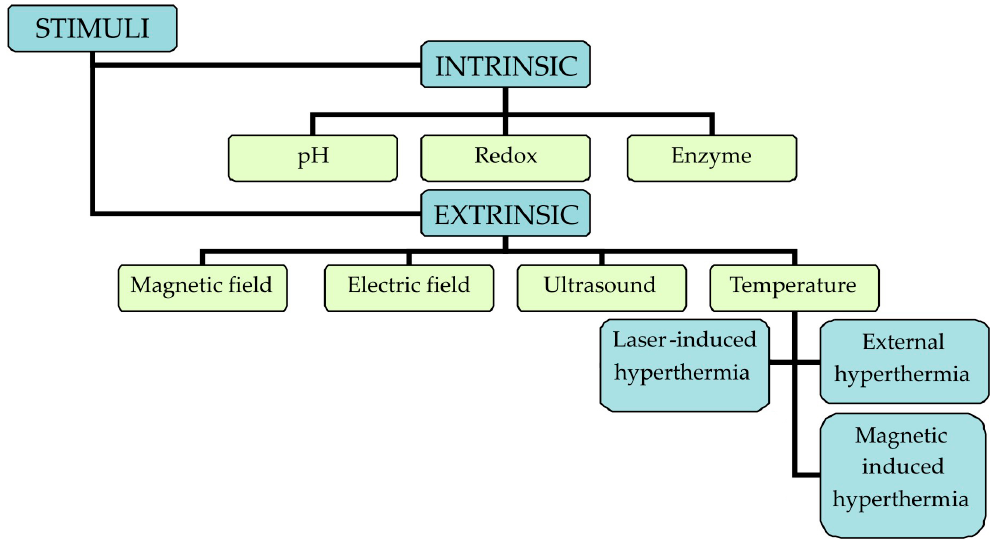
Figure 7. Types of stimuli.